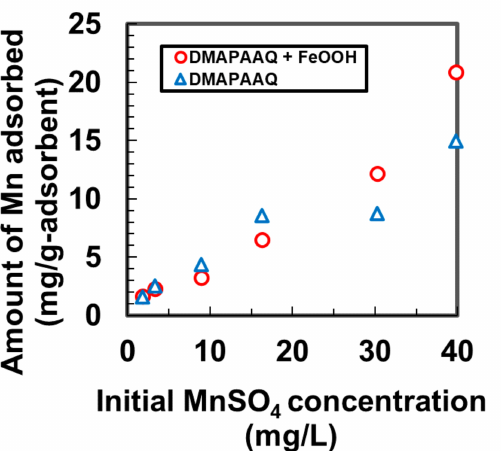
Figure 1. Amount of Mn adsorbed by DMAPAAQ and DMAPAAQ + FeOOH at different initial concentrations of MnSO 4 .